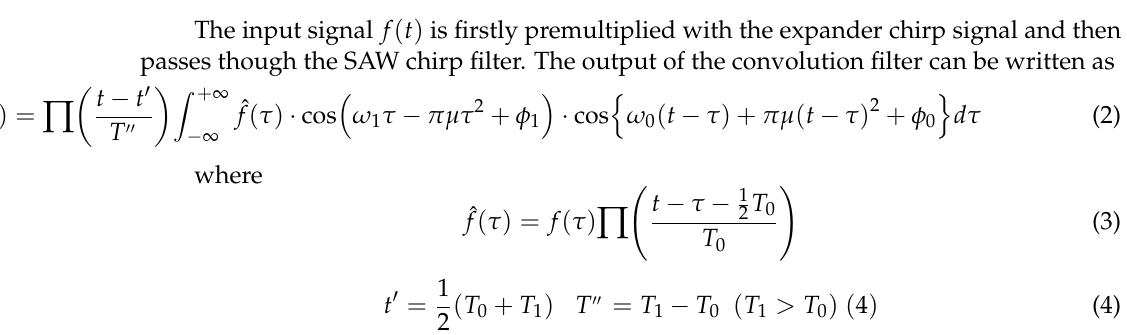
Figure 1. M(l)-C(s) chirp transform processor arrangement.